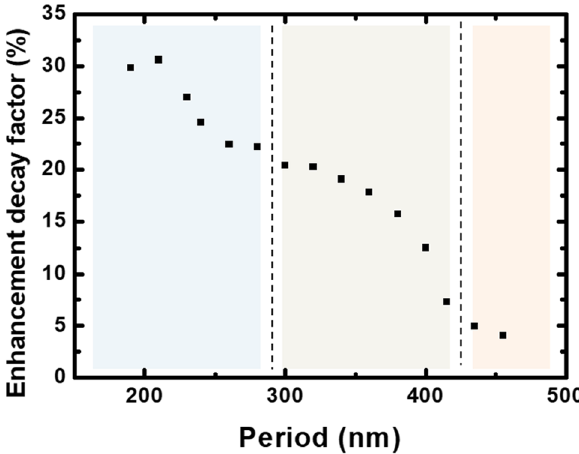
Figure 4. The evolution of the enhancement factors associated to the dye molecules Alq3: DCM as function of the period. Three zones can be distinguished p ≤ 280 nm, 280 nm < p ≤ 430 nm and p > 430